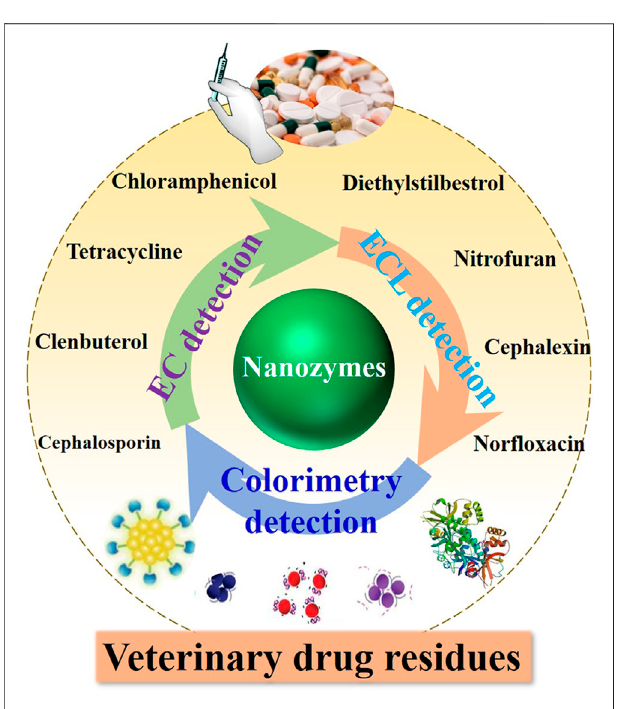
FIGURE 9 | Schematic illustration of nanozymes in the design of detection platforms for veterinary drug residues as multifunctional sensing